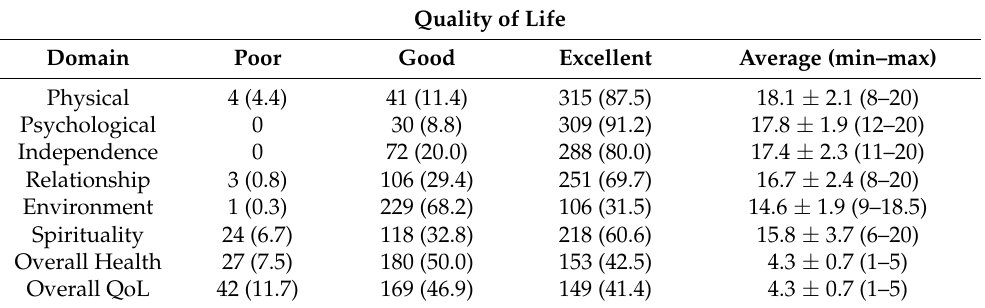
Table 3. Quality of Life of participants.